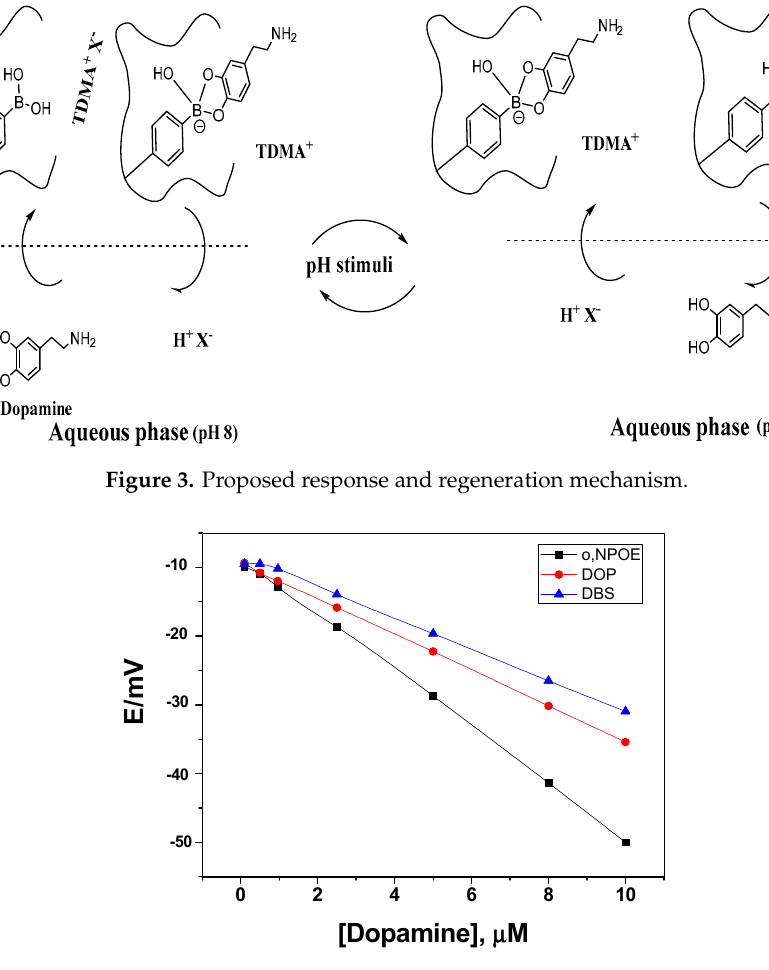
Figure 4. Effect of plasticizers on the membrane response.